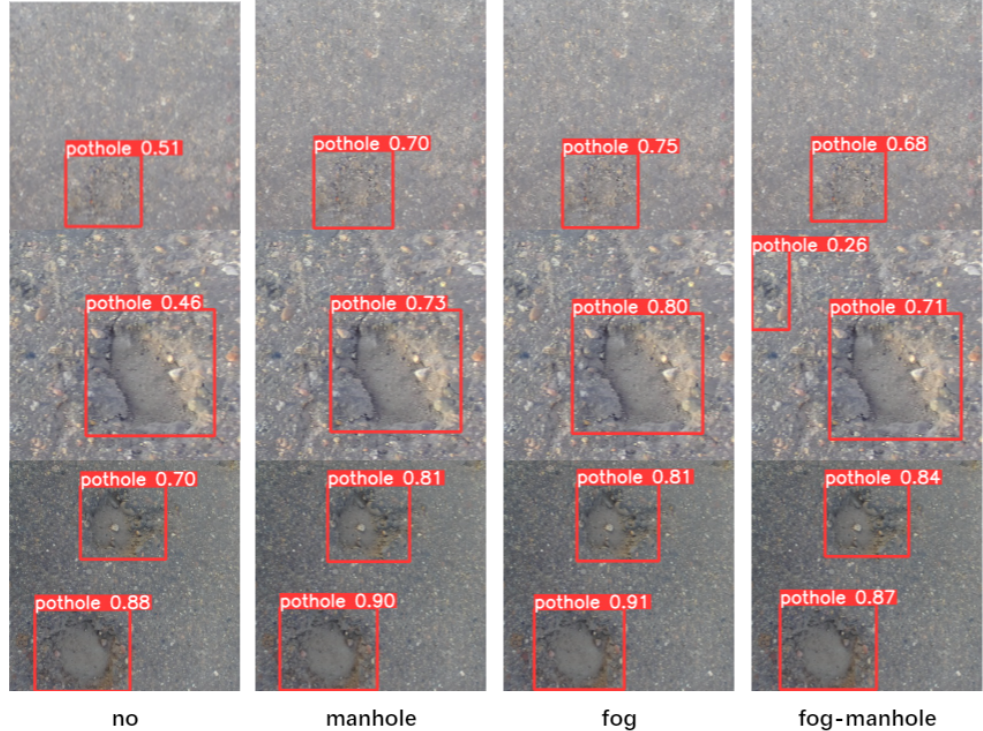
Figure 15. Visualization of images detected on the pothole600 dataset using different data augmenta- tion